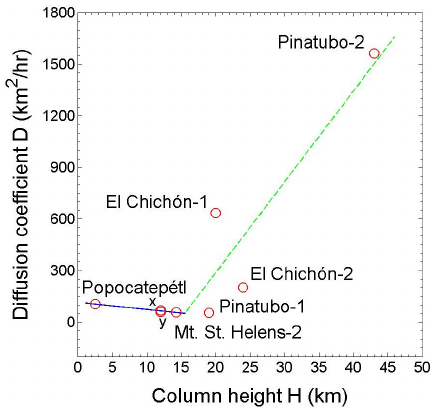
Fig. 8. Best linear fit (solid line) between the effective diffusion coefficient D and the eruptive column maximum heights H , for se- lected eruptions: Popocat´epetl (21 December 1994); x=Hudson-1 (8–9 August 1991); y=Usu (7–9 August 1977); Mt. St. Helens- 2 (18 May 1980), 09:00; Pinatubo-1 (12 June 1991); El Chich´on-1 (28 March 1982); El Chich´on-2 (3 April 1982); Pinatubo-2 (15 June